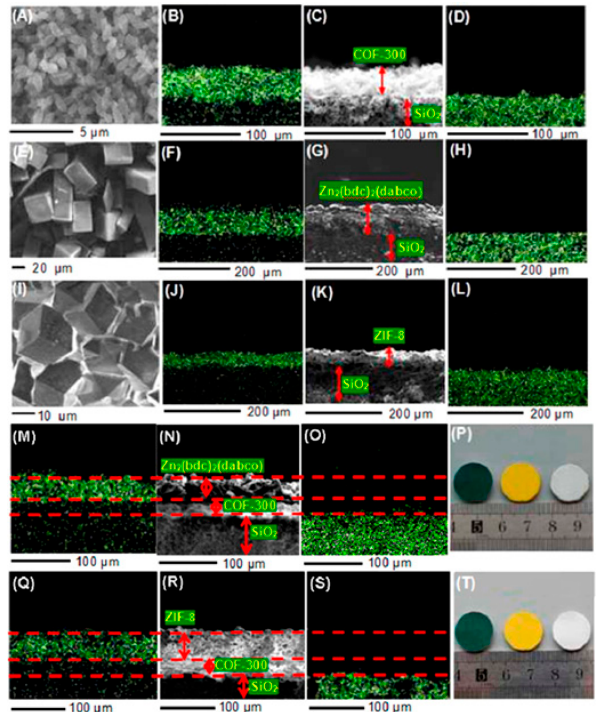
Figure 43. COF-300 membrane: ( A ) SEM top view, ( B ) elemental mapping image (carbon), ( C ) SEM cross-sectional view, and ( D ) elemental mapping image (silicon). Zn 2 (bdc) 2 (dabco) membrane: ( E ) SEM top view, ( F ) elemental mapping image (zinc), ( G ) SEM cross-sectional view, and ( H ) elemental mapping image (silicon). ZIF-8 membrane: ( I ) SEM top view, ( J ) elemental mapping image (zinc), ( K ) SEM cross-sectional view, and ( L ) elemental mapping image (silicon). [COF-300]-[Zn 2 (bdc) 2 (dabco)] composite membrane: ( M ) elemental mapping image (zinc), ( N ) SEM cross-sectional view, ( O ) elemental mapping image (silicon), and ( P ) photo image. [COF-300]-[ZIF-8] composite membrane: ( Q ) elemental mapping image (zinc), ( R ) SEM cross-sectional view, ( S ) elemental mapping image (silicon), and ( T ) photo image. (adapted with permission from ref. [137]).